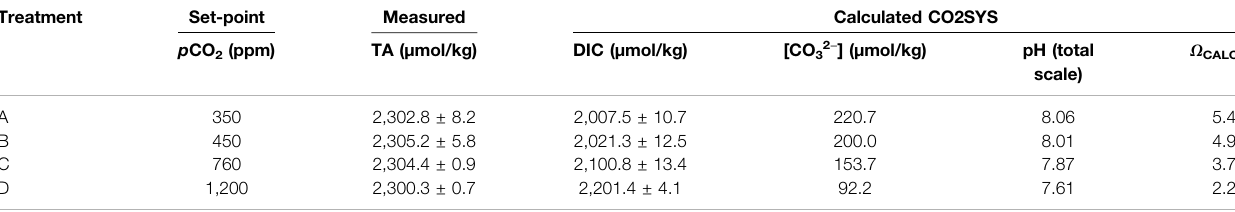
TABLE 1 | Carbon parameters of the culture media per p CO 2 set-point. Treatment